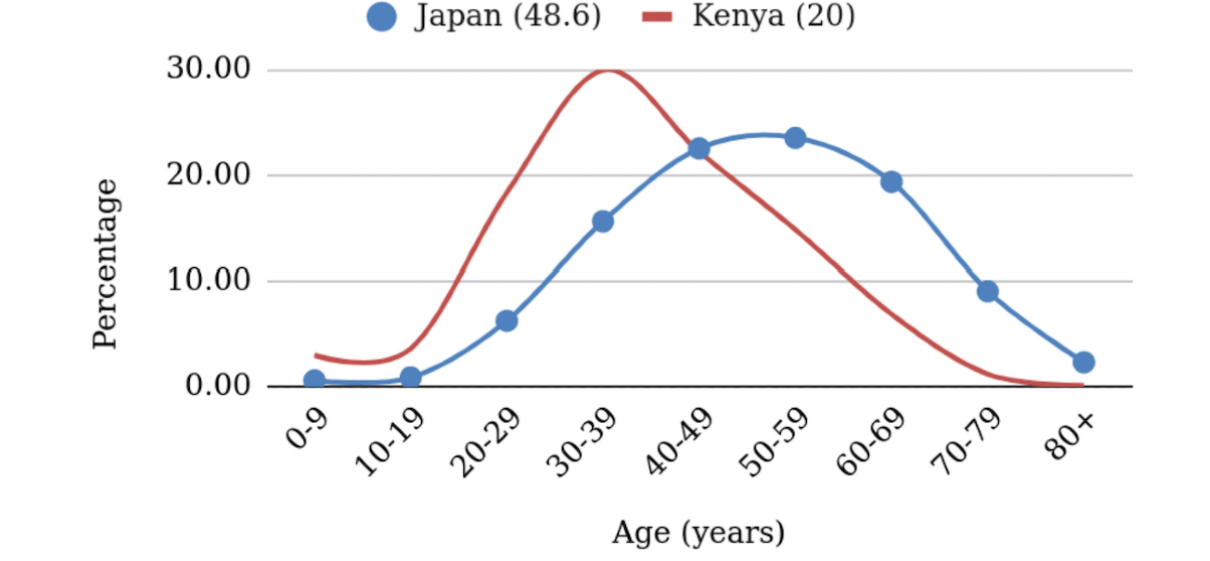
Figure 3. Projected age-stratified percentages of cases for Japan and Kenya. The average age in each country is given in